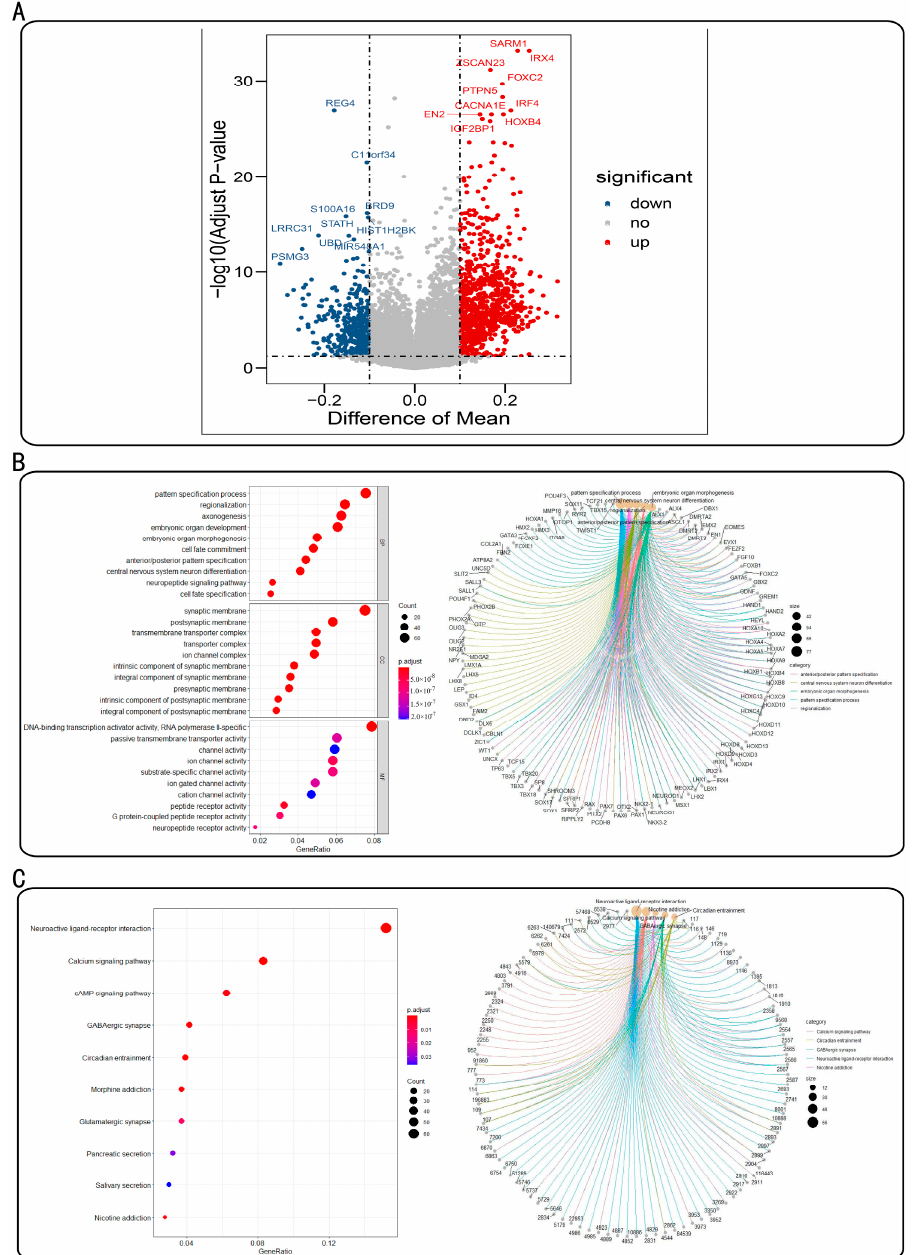
Figure 1. ( A ) Distribution of differentially methylated genes in PAAD. ( B ) Gene ontology (GO) enrich- ment analysis of differentially methylated genes. Bubble diagram of GO enrichment analysis results and several of the most prominent GO terms associated with the genes. ( C ) Kyoto Encyclopedia of Genes and Genomes (KEGG) pathway enrichment of differentially methylated genes. Bubble diagram of KEGG enrichment and several of the most prominent pathways analysis results for the enriched genes. In the bubble graphs, the horizontal axis is GeneRatio, representing the proportion of genes contained in each enriched function or pathway in the total genes involved in the analysis, and the name of the enriched function or pathway is presented on the vertical axis. The size and color gradient of dots represent the number of genes and p -value. Small circles of the network diagram represent the most prominently enriched function or pathway name, distinguished by different colors, and genes in these entries are connected by corresponding color